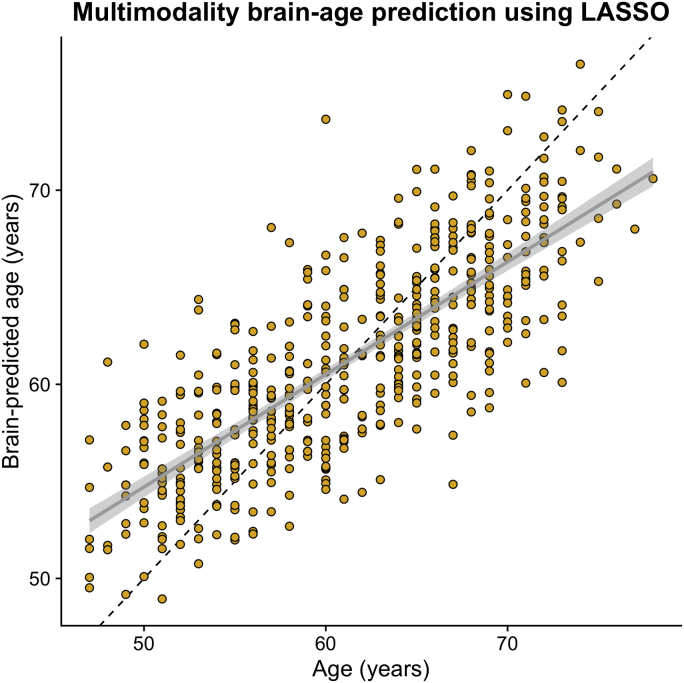
Brain-predicted age from multimodality LASSO regression model. Scatterplot depicting chronological age (x-axis) by brain-predicted age (y-axis) in UK Biobank validation set (n = 520). Black line is the line of identity. Gray line is the regression line of age on brain-predicted age with shaded errors representing the 95% confidence intervals. No age-bias correction had been applied at this stage.